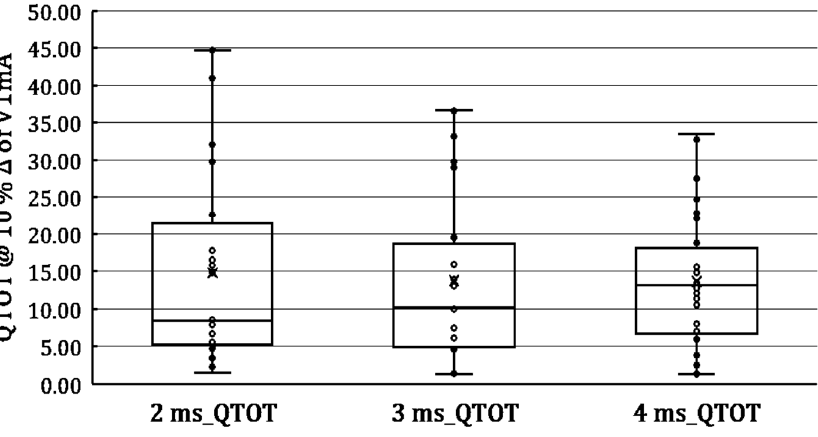
Figure 2. UV side-by-side boxplot of 2, 3, and 4 ms DC surged samples.